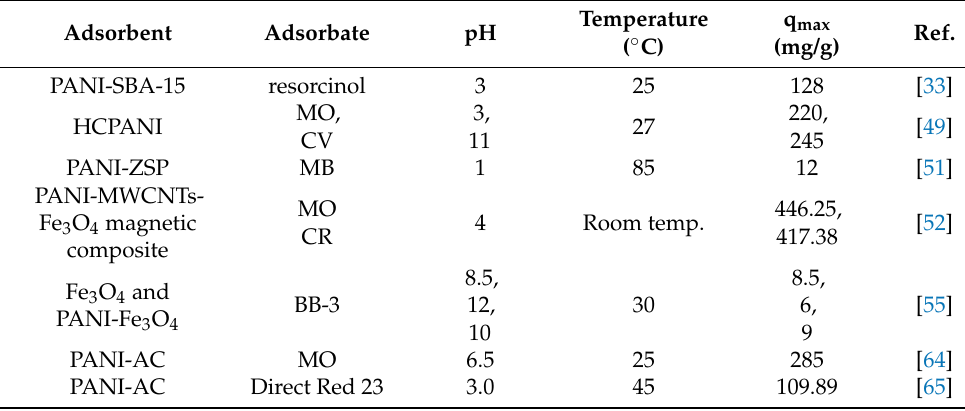
Table 3. PANI-based adsorbents for the removal of ODs and other organic